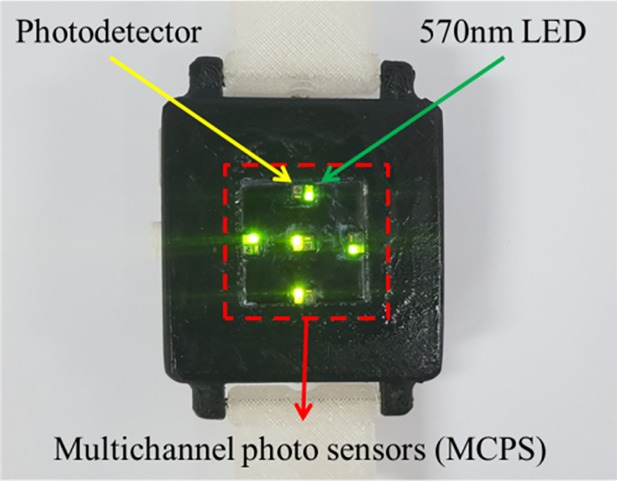
DCRW bottom view.